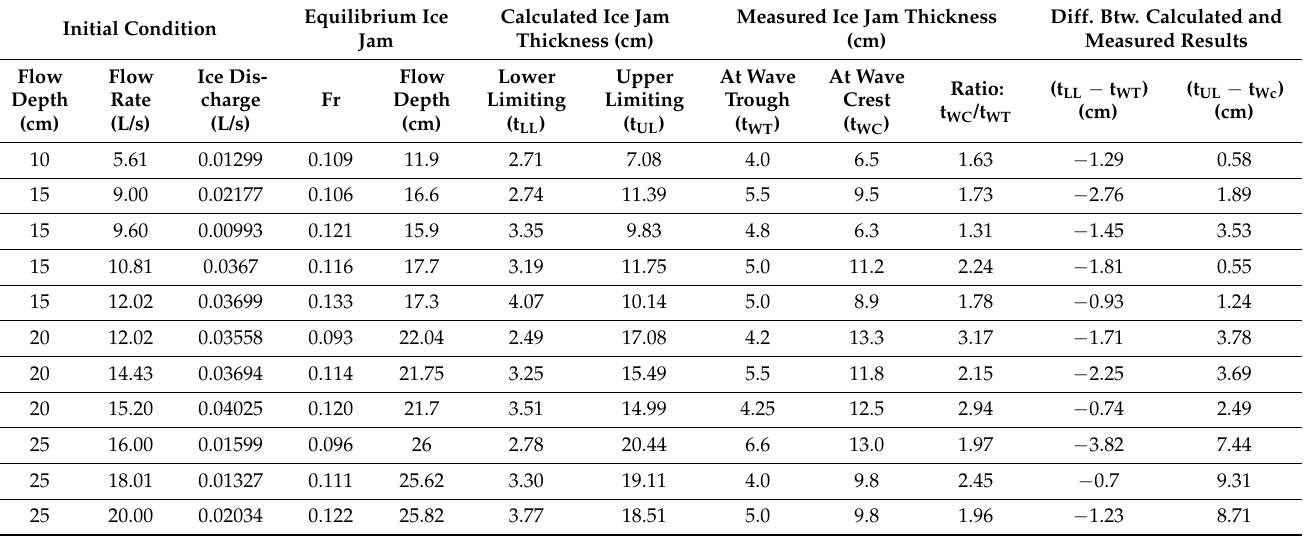
Table 3. Calculated results of ice jam thickness at wave crest and trough compared to those of laboratory